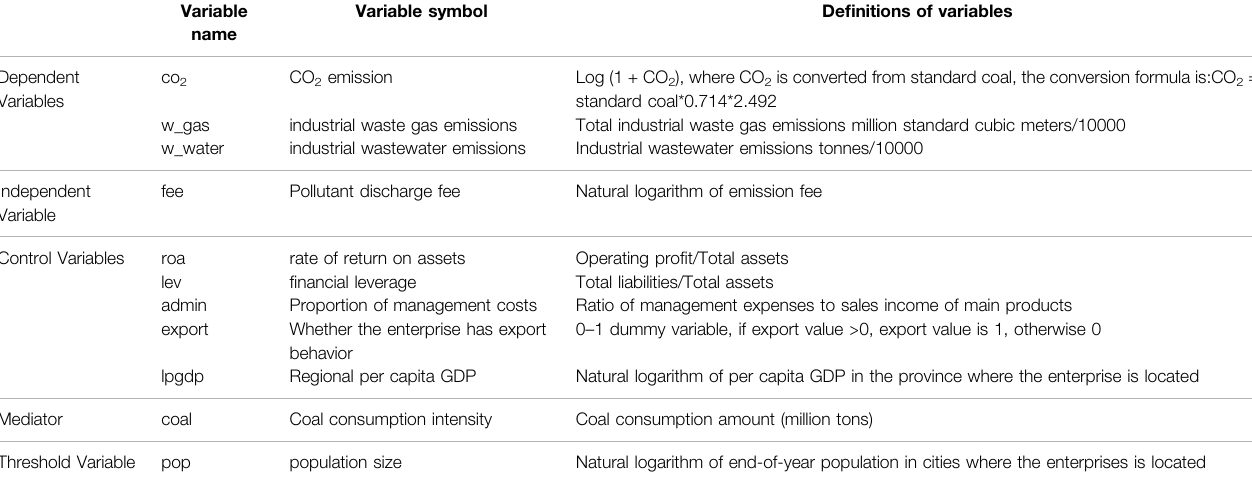
TABLE 1 | De fi nitions of variables.